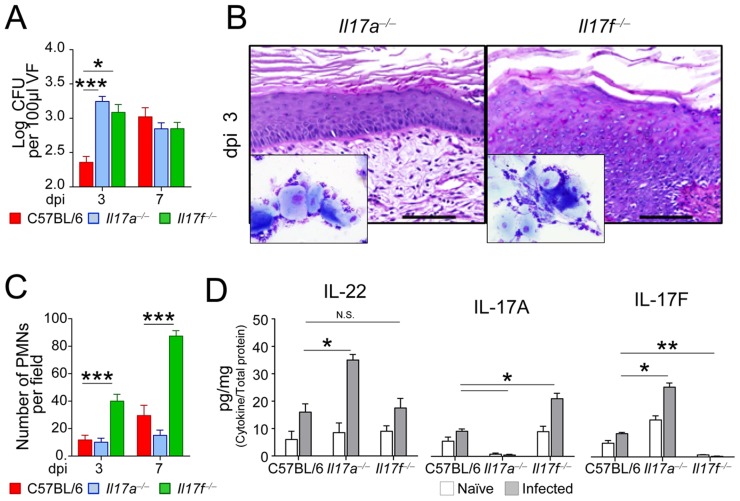
Vaginal candidiasis in IL-17A- or IL-17F-deficient mice.(A) Vaginal fungal burden in C57BL/6, IL-17A- or IL-17F-deficient mice (n = 6) intravaginally inoculated with 5×106
C. albicans blastospores. CFU were quantified by culturing serial dilutions of vaginal fluid (VF) from each mouse at different days post-infection (dpi) and expressed as Log10 CFU/100 µl VF ± s.e.m. Pooled data from 3 experiments. (B) Histological analysis of periodic acid-Schiff-stained vaginal sections and inflammatory cell recruitment in vaginal fluids (May–Grünwald Giemsa staining in the insets) at 3 dpi. Representative images (out of 3 experiments) of histology sections and vaginal fluids were acquired with a 40× and 100× objective respectively. Scale bars, 100 µm. (C) Polymorphonuclear cells (PMNs) quantification in the vaginal fluids at different dpi. PMNs were identified by nuclear morphology and enumerated per field at ×100 magnification. Each point represents an individual mouse, and horizontal bar indicates the means. (D) Cytokine levels (pg/mg, cytokine/total proteins for each sample) in the vaginal fluids of naïve or infected (3 dpi) mice. Data are pooled or representative (histology) from 3 independent experiments. * P<0.05, **P<0.01, ***P<0.001, knockout vs. wild-type mice. N.S., not significant.